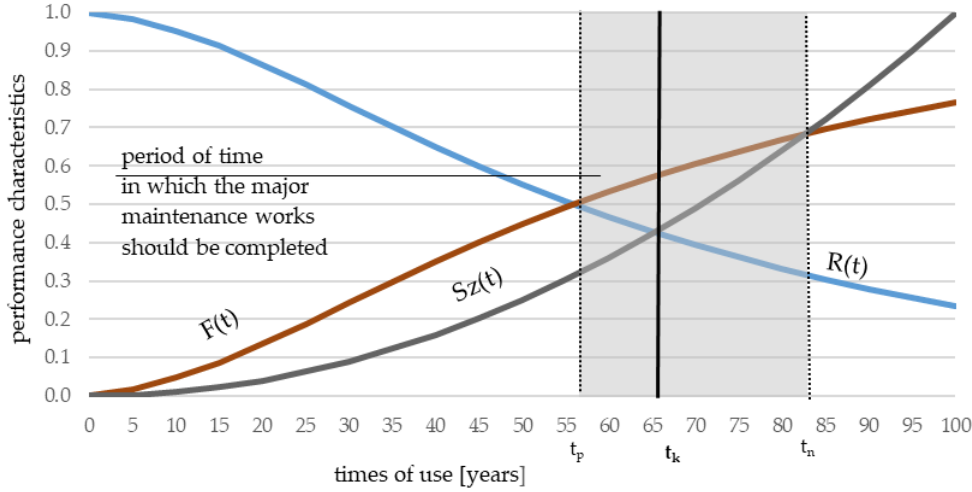
Figure 4. Functions describing the aging process of a building.